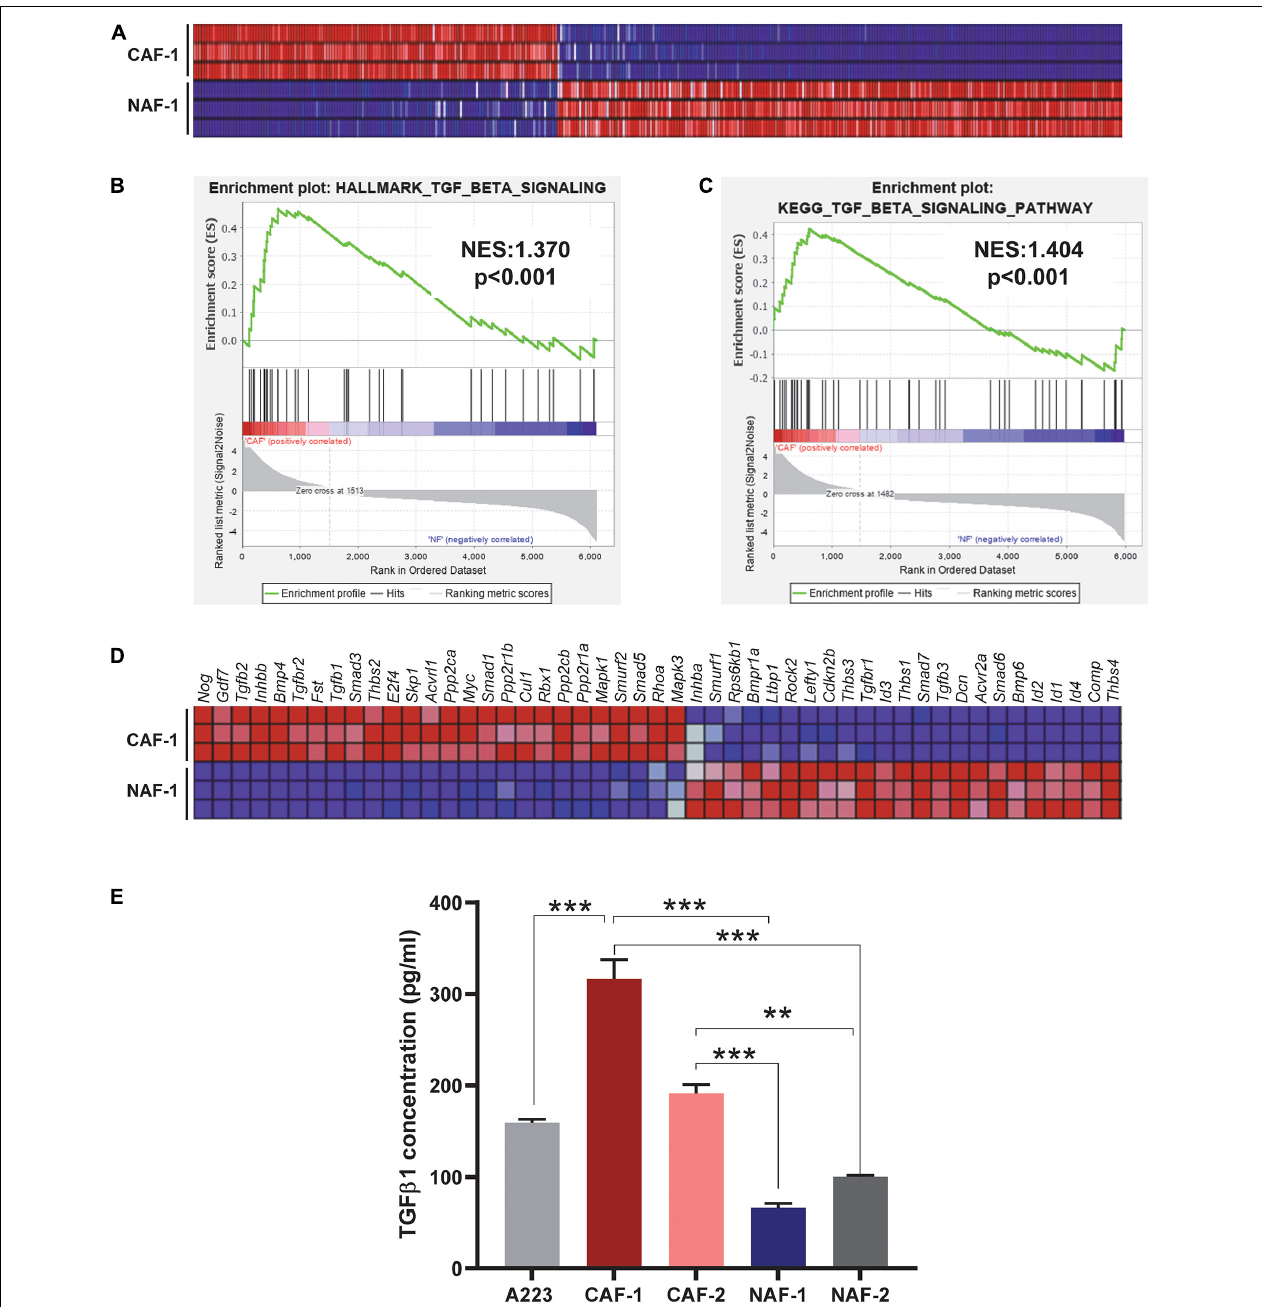
FIGURE 1 | TGF β signaling is activated in CAFs. (A) Heat map of all differentially expressed genes comparing three technical replicates of the CAF-1 to NAF-1 cell lines ( P < 0.05). (B,C) GSEA analysis of the Hallmark Gene Sets (B) and the KEGG Pathways Gene Sets (C) identified enrichment of TGF β signaling in CAFs compared to NAFs. NES: normalized enrichment score. (D) Heat map of differentially expressed genes between CAFs and NAFs in the KEGG TGF β signaling pathway. (E) Detection of TGF β 1 in conditioned media of SCCs, CAFs, and NAFs was performed using ELISA. Either three or four technical replicates were conducted for each cell type and two independent CAF cell lines and two independent NAF cell lines were utilized. CAF-1 and CAF-2 cell lines were derived from two different, independent SCC tumors. NAF-1 and NAF-2 cell lines were derived from the tongues of two different wild type non-tumor-bearing C57BL/6J mice. ** P < 0.01, *** P <